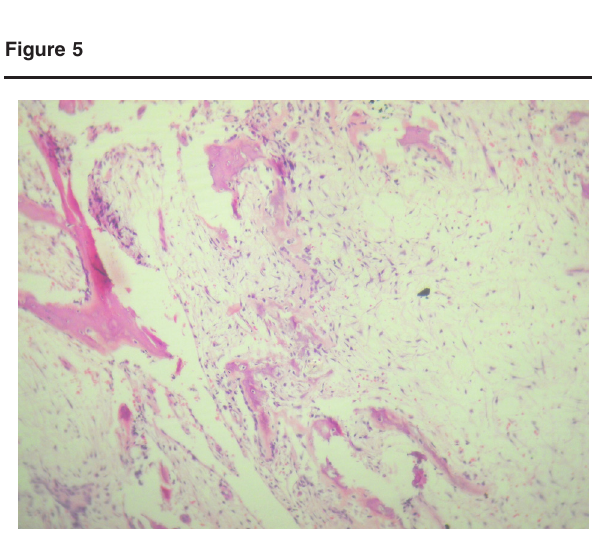
Histopathological picture of myxoma (×40